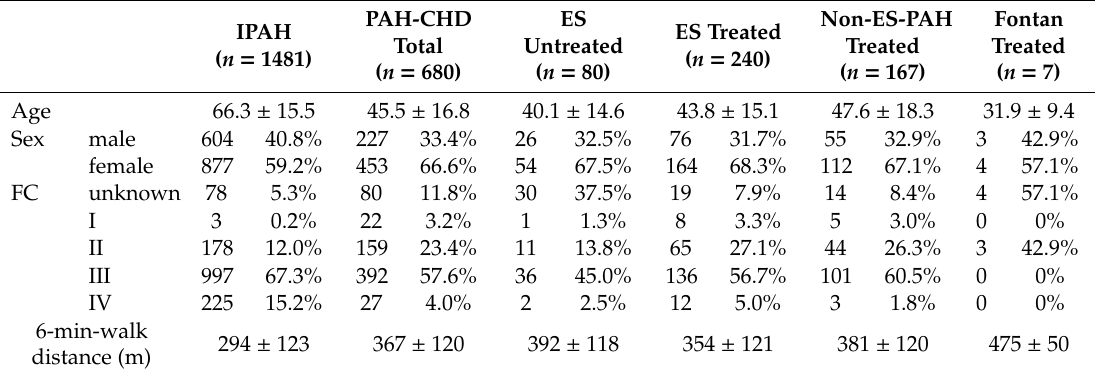
Table 1. Demographics and clinical characteristics at enrollment.